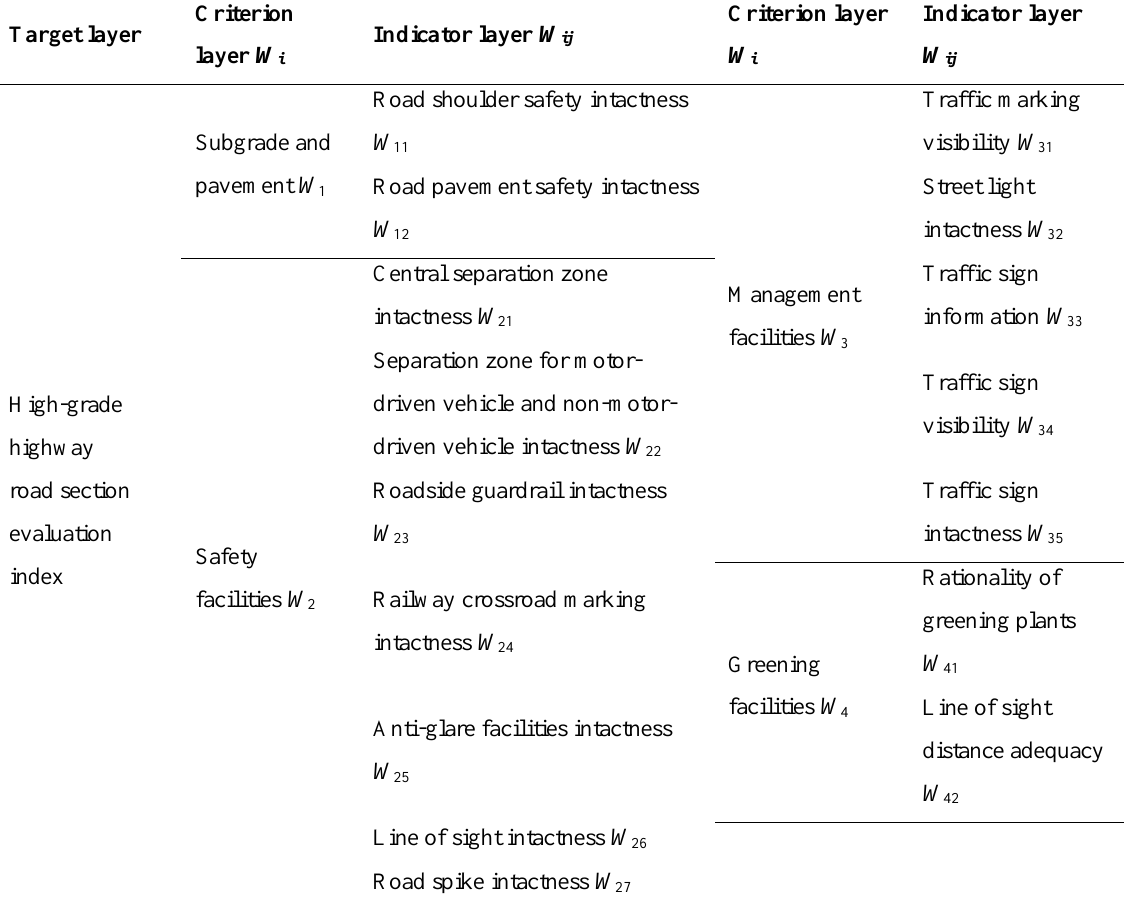
Table 1 Evaluation indicator system of the high-grade highway